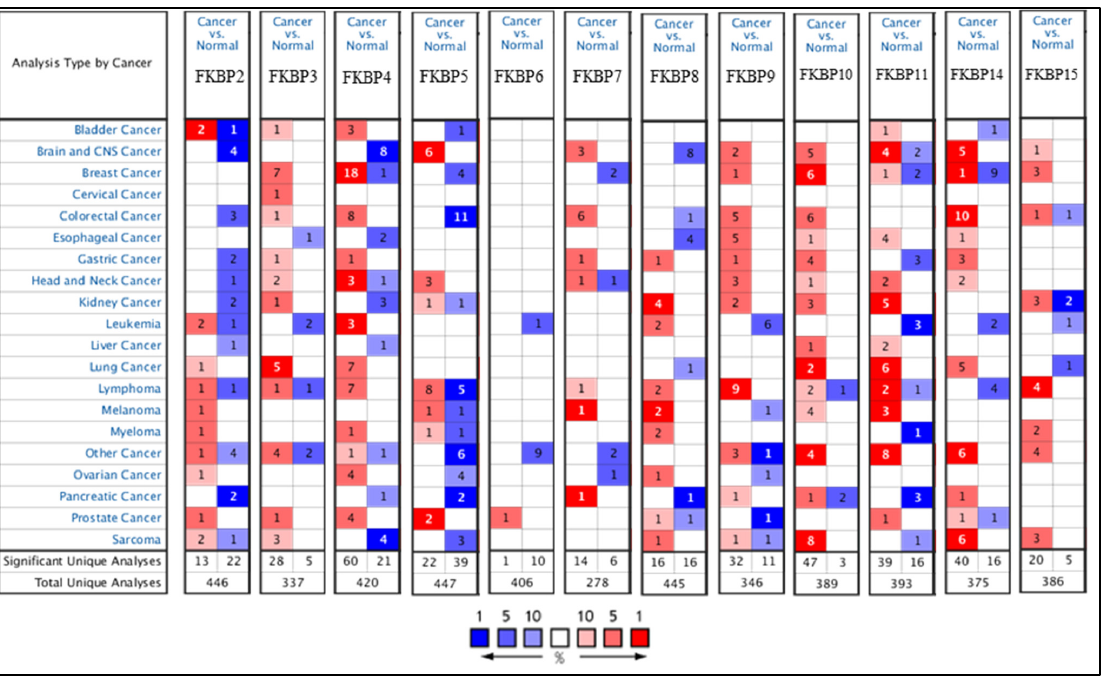
Figure 1. The mRNA expression levels of FKBP family members in various cancer types analyzed using the Oncomine database. Transcriptional levels of FKBP2 , FKBP3 , FKBP4 , FKBP10 , FKBP11 , and FKBP14 were higher in lung cancer samples than in normal samples. Red and blue cells, respectively, represent statistically upregulated and downregulated mRNA expression levels of FKBP family members. The threshold was set to a fold change of p <0.05; fold change >1.5 p=0.05; gene rank top 10%.